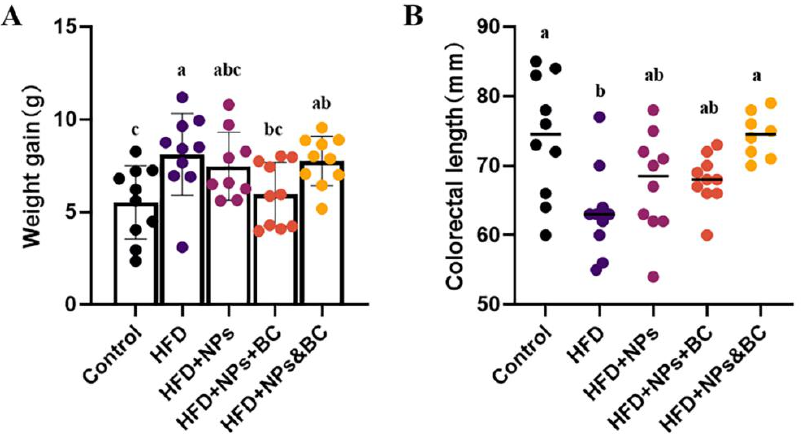
Figure 1. The effects on the body weight and colorectal length of mice in different groups. ( A ) The net weight gain before and after treatment in each group. ( B ) The colorectal length in different treatments. The different letters represent significant differences among groups ( p < 0.05).